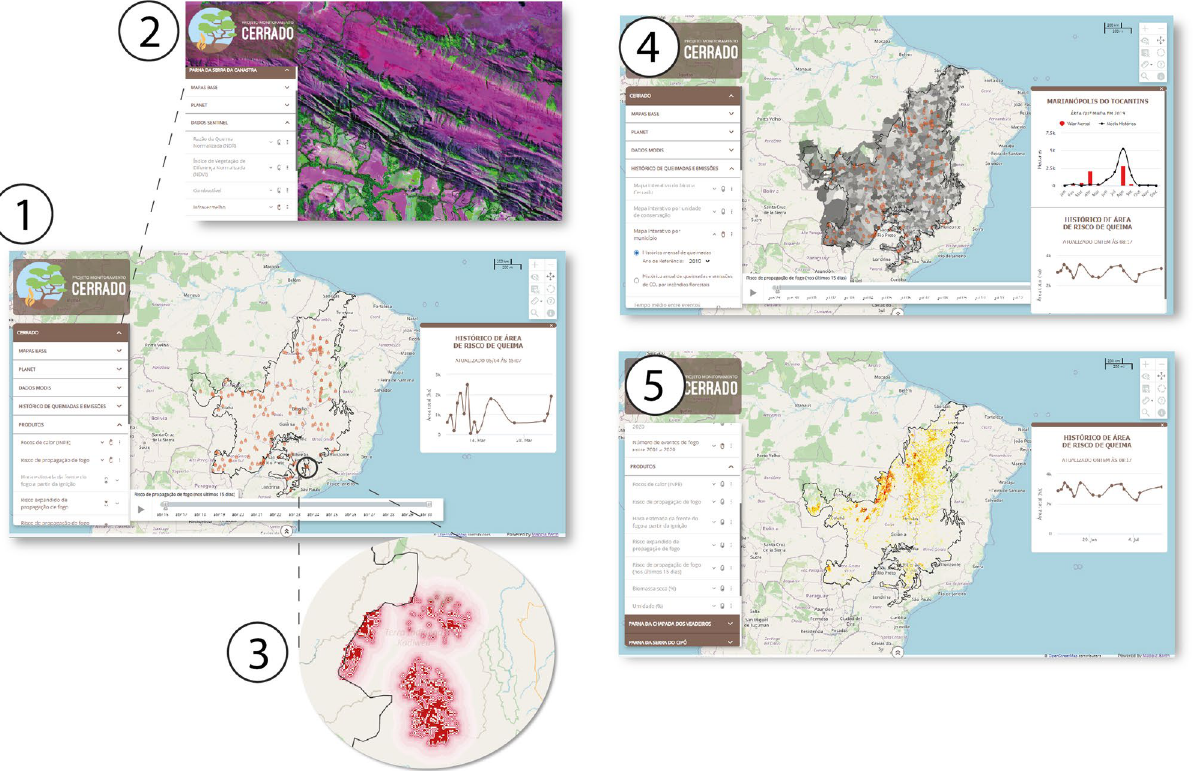
Figure 2. FISC-Cerrado web interface. 1—home page depicting hot pixels; 2—high spatial resolution map of fuels loads; 3—zoom on the map of fire spread risk; 4—graphs from map query showing the frequency of fires for the year of reference (bars) and its historical average per municipality; 5—frequency of burned areas. Maps created using Dinamica EGO (https:// dinam icaego. com/).